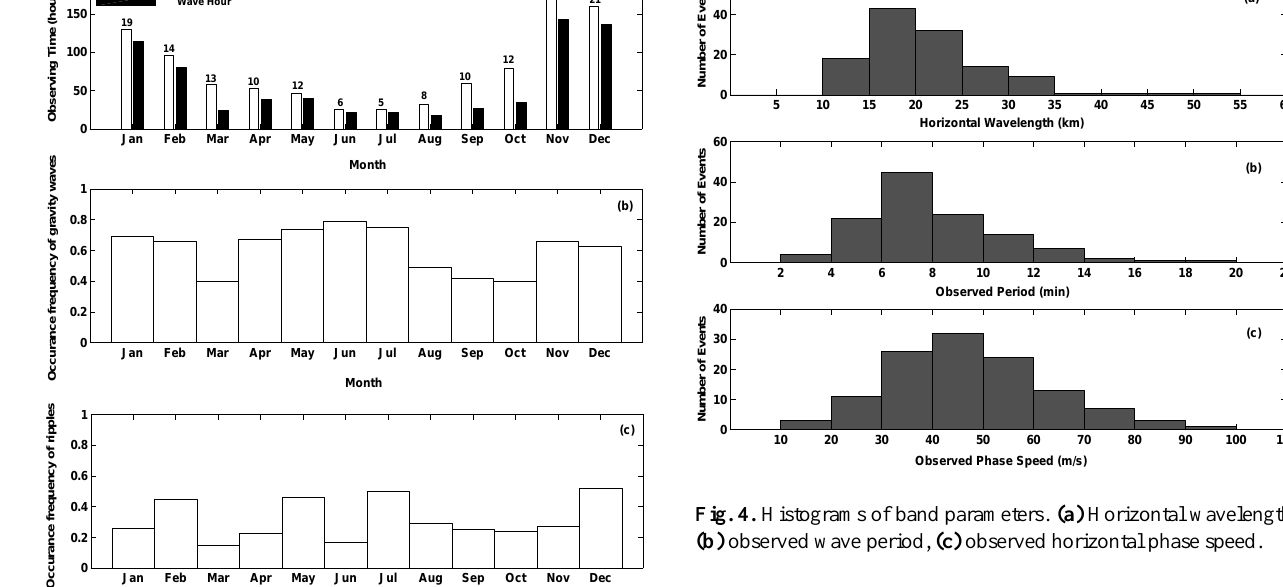
of 22 ± 7 km (here, 22 is the average value, ± 7 is the standard deviation), observed wave periods (Fig. 4b) are 4–14 min with an average value of 8 . 1 ± 3 . 0 min. And observed hor- izontal phase speeds (Fig. 4c) are 30–60 m s − 1 , with an av- erage value of 48 ± 16 m s − 1 . Compared to the AGW pa- rameters observed at similar latitudes, Smith et al. (2000) gave similar parameters of band events, with an average horizontal wavelength of 21 ± 7 km, an average observed period of 8 . 5 ± 4 . 6 min, and an average observed horizon- tal phase speed of 47 ± 20 m s − 1 , respectively, at Millstone (42.6 ◦ N, 71.5 ◦ W). Ejiri et al. (2003) reported an average horizontal wavelength of 21 km from OH airglow images and slightly slower observed horizontal phase speed of 20– 50 m s − 1 from both OH and OI airglow images at Rikubetsu (43.5 ◦ N, 143.8 ◦ E) and Shigaraki (34.9 ◦ N, 136.1 ◦ E). Furthermore, Fig. 5 illustrates the seasonal variations in the averaged parameters of band events. It should be noted that there are no significant seasonal variations of horizon- tal wavelengths (Fig. 5a). Ejiri et al. (2003) also reported there were no recognizable variations of the average hori- zontal wavelengths at Rikubetsu (43.5 ◦ N, 143.8 ◦ E) and Shi- garaki (34.9 ◦ N, 136.1 ◦ E) from both OH and OI airglow im- ages (see the Fig. 6 in Ejiri et al., 2003). Figure 5b indicates larger observed period in summer than in winter. Figure